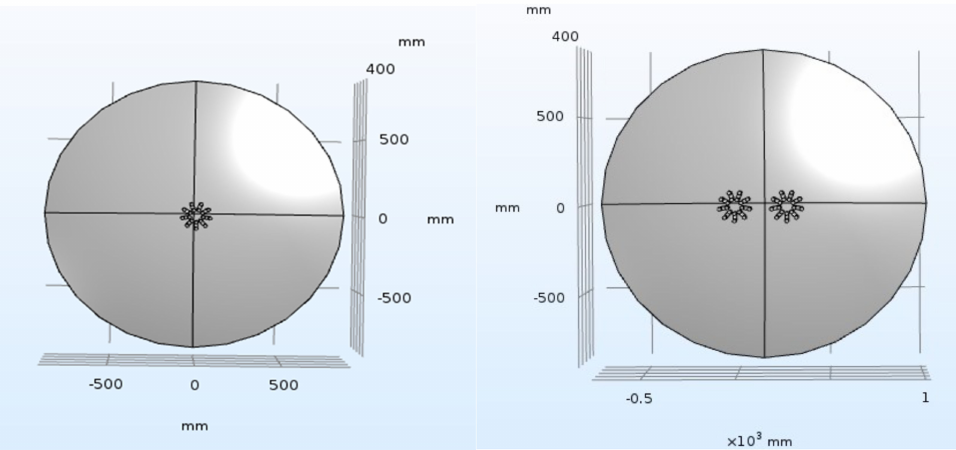
Figure 7. Configurations for the CFD